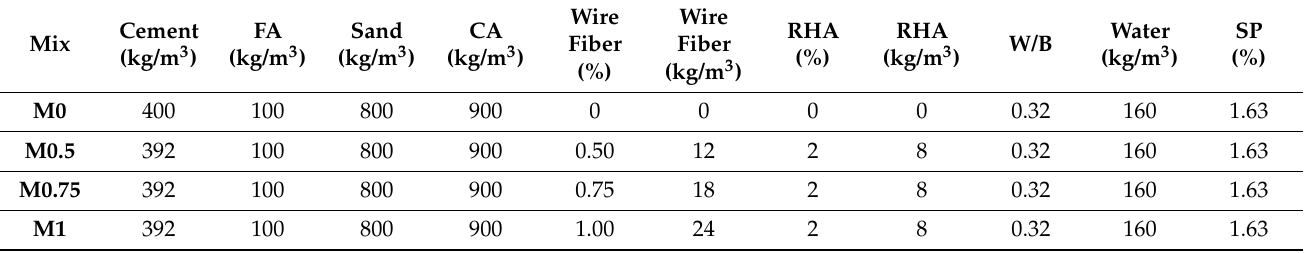
Table 5. Mixing proportion of